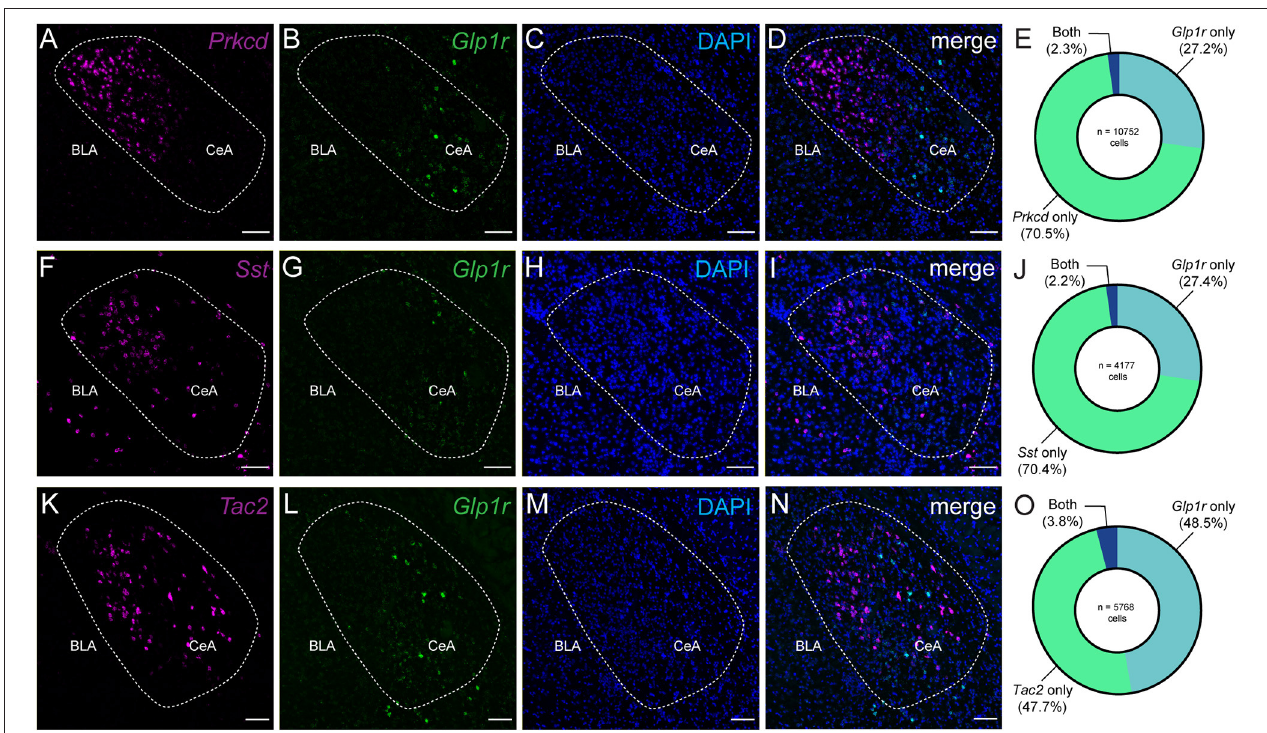
FIGURE 1 | The Glucagon-like peptide 1 receptor is expressed diffusely amongst known genetic markers of the central amygdala. (A–D) Example single channel and merged images of Prkcd , Glp1r, and DAPI mRNA in the CeA of wild type mice. (E) Donut plot depicting percentages of Prkcd, Glp1r , and double-labeled cells. (F–I) Example single channel and merged images of Sst , Glp1r, and DAPI mRNA in the CeA of wild type mice. (J) Donut plot depicting percentages of Sst, Glp1r , and double-labeled cells. (K–N) Example single channel and merged images of Tac2 and Glp1r mRNA, and DAPI in the CeA of wild type mice. (O) Donut plot depicting percentages of Tac2, Glp1r , and double-labeled cells. For (E,J,O) , count data were obtained from 6 to 8 images acquired from 4 wildtype C57BL6/J mice (2 male and 2 female) with 3–4 images per hemisphere per mouse. (E) A total of 10,752 cells were counted with 2,688 ± 558 (s.e.) cells counted per animal. (J) A total of 4,177 cells were counted with 1,044 ± 82.2 (s.e.) cells counted per animal. (O) A total of 5,788 cells were counted with 1,442 ± 229 (s.e.) cells counted per animal. Scale bar = 100 µ m for all